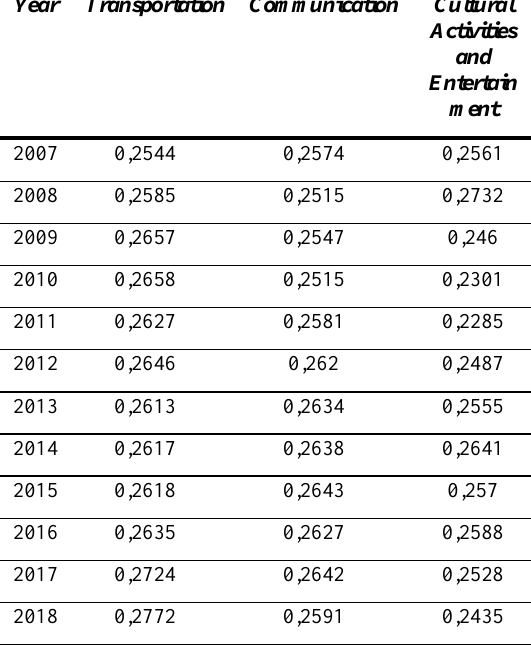
Table 3: Gini Coefficients of Transportation, Communication, Cultural Activities